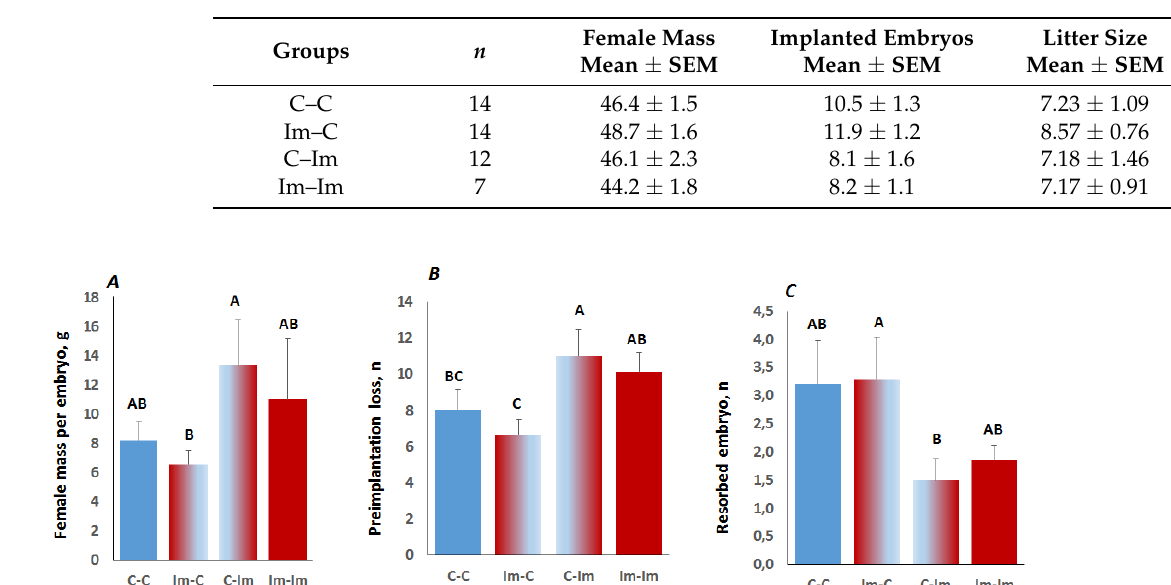
Table 2. Body mass of pregnant CD1 female mice, number of implanted embryos, and litter size on day 16 of pregnancy.